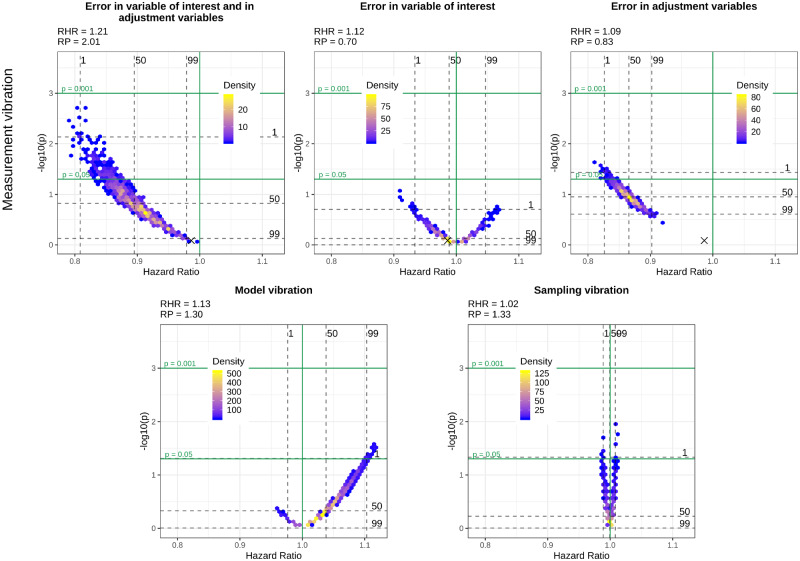
Volcano plots for different types of vibration and different scenarios of measurement vibration when HDL-cholesterol is the variable of interest. The black cross in the top panel indicates the model without measurement error